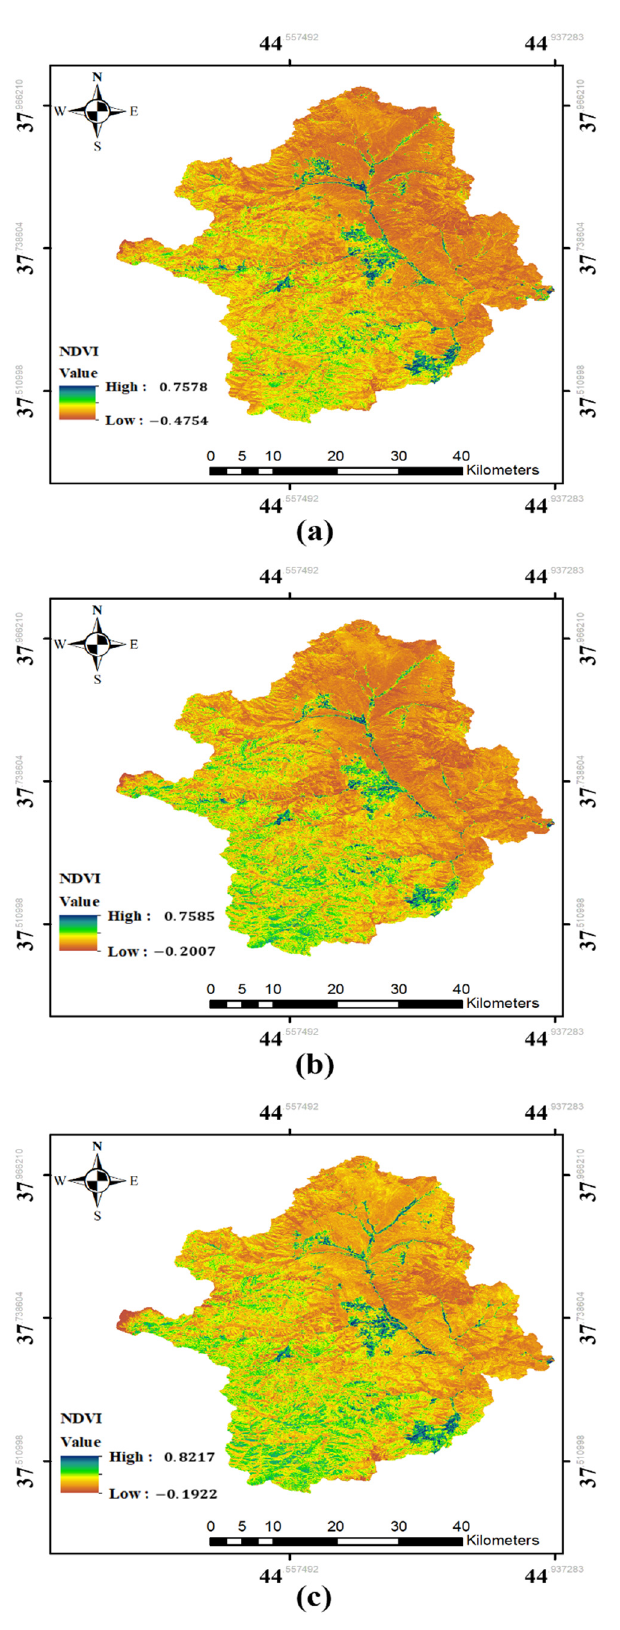
Figure 7. The average NDVI maps over the NC watershed for ( a ) 1990–2000, ( b ) 2000–2010, ( c ) 2010–2020.